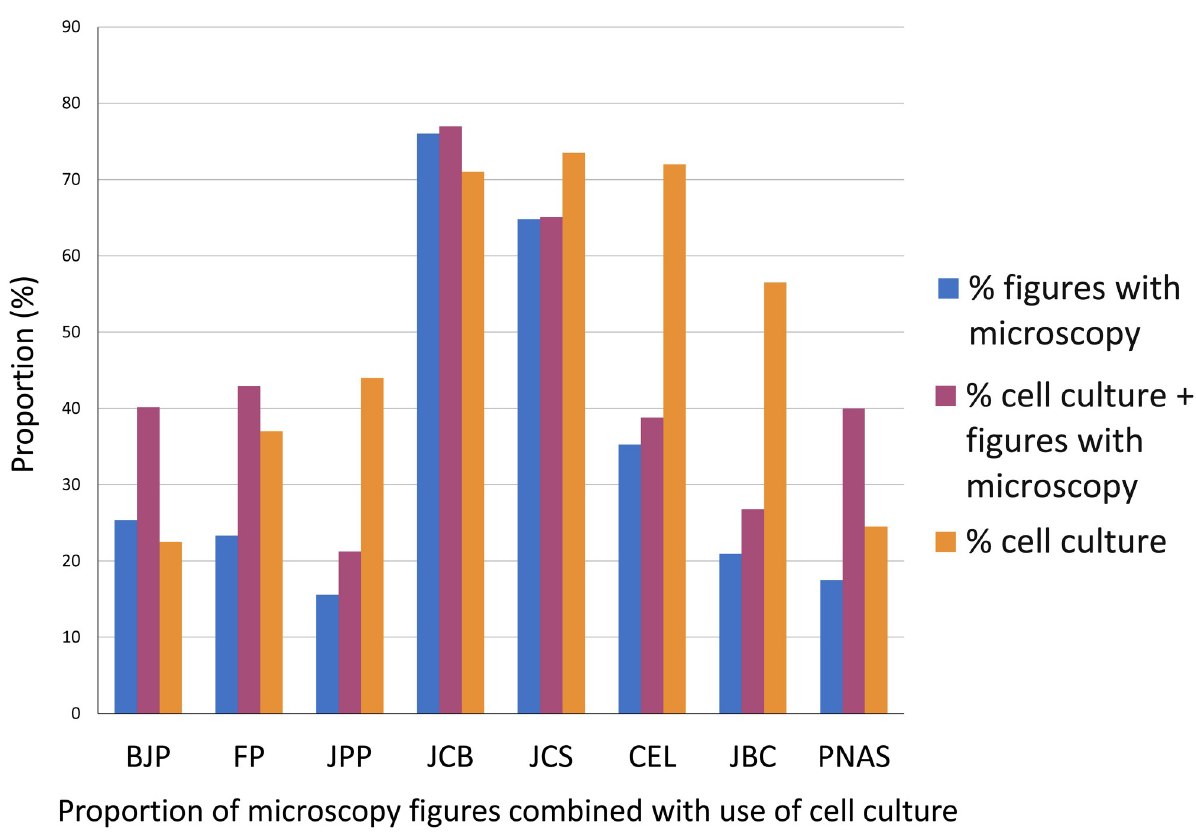
Fig 4. Comparative analysis of the percentage of articles figures with microscopy and cell culture in biomedical sciences journals. The percentage of figures containing microscopy images is shown in blue bars, the percentage of articles containing cell culture is shown in orange bars and the percentage of articles containing cell culture and microscopy is shown in magenta. Data were collected from articles published in 2019 in the biomedical sciences journals: British Journal of Pharmacology (BJP), Journal of Pharmacy and Pharmacology (JPP), Frontiers in Pharmacology (FP), Journal of Cell Biology (JCB), Journal of Cell Science (JCS), Cells (CEL), Journal of Biological Chemistry (JBC) and Proceedings of the National Academy of Sciences (PNAS). N = 200 articles analyzed in each scientific